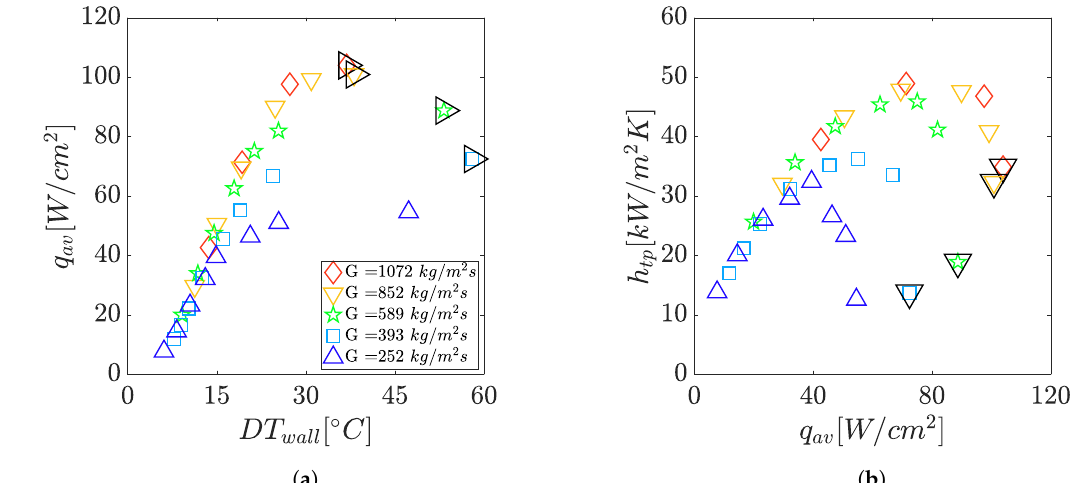
Figure 9. Boiling curves ( a ) and channel average heat transfer coefficient ( b ) in Geometry A for a nominal saturation ◦ temperature of 30 C at the outlet of the channels.